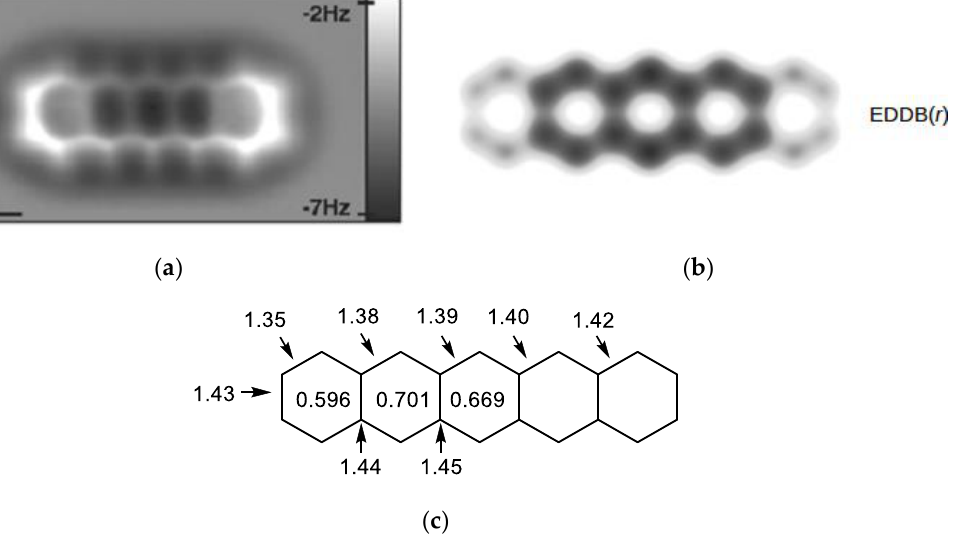
Figure 10. This pentacene molecule: ( a ) AFM image, ( b ) isosurfaces of EDDB(r), and ( c ) experimental bond lengths (in Å, from Ref. [53]) along with HOMA of each ring. The AFM image is reproduced from Ref. [119] with permission from AAAS. The EDDB(r) representation is reproduced from Ref. [99] with permission from the PCCP Owner Societies. Copyright (2018) with permission from the Royal Society of Chemistry.